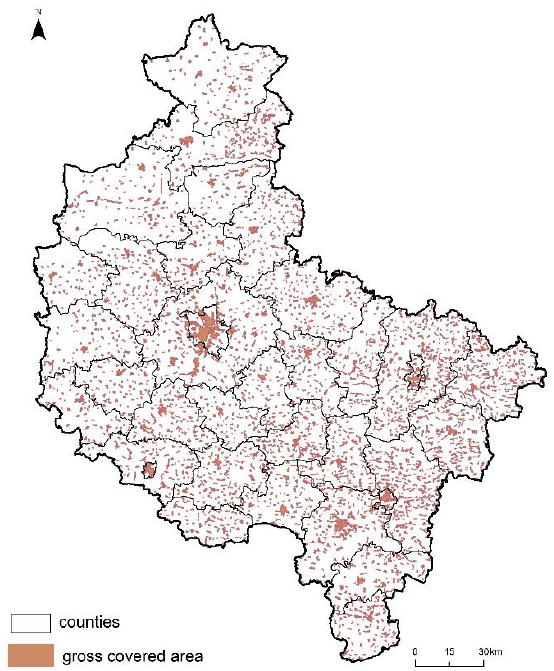
Figure 10. The gross covered area in the Greater Poland Voivodeship (own calculations).